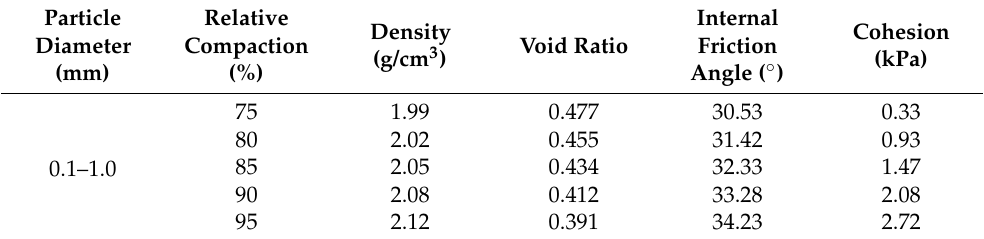
Table 6. The physical mechanical parameters of lunar soil